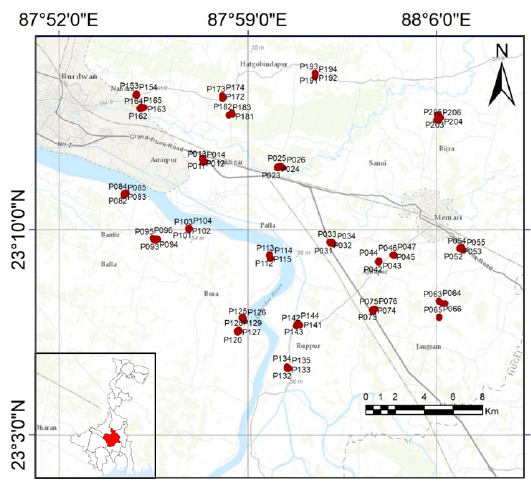
Figure 1. Location of sampling fields in study